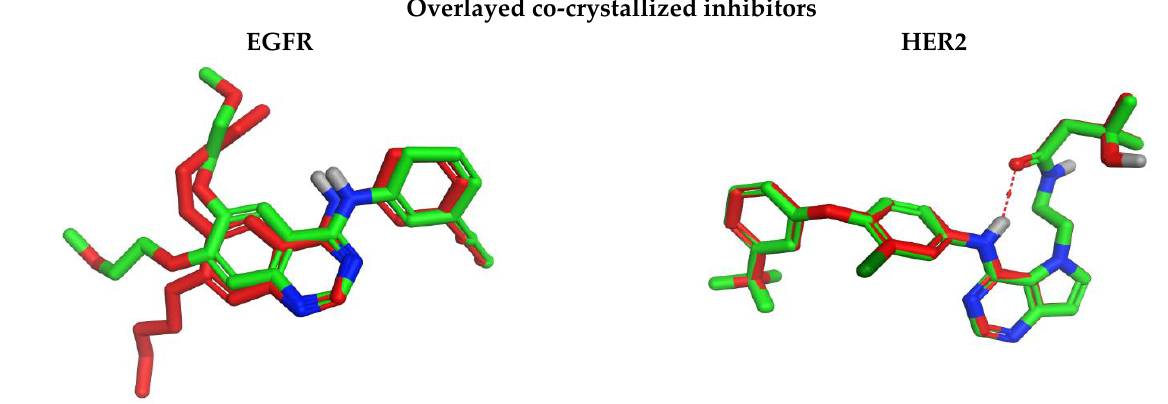
Figure 3. Overlaying of the native (green) and re-docked (red) co-crystallized ligands of EGFR and HER2 binding pockets.